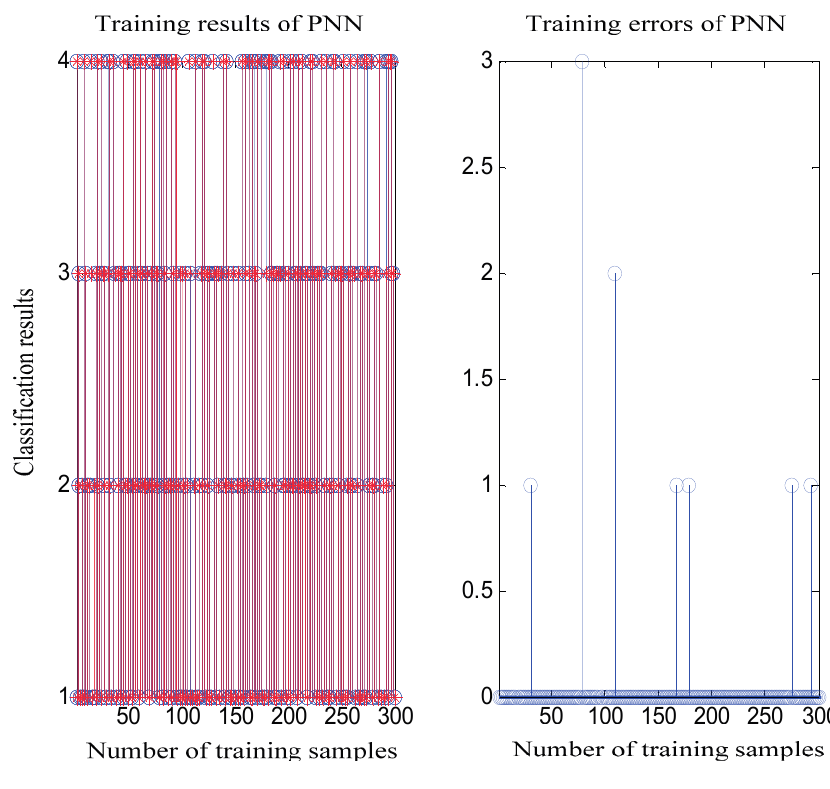
Figure 8. Classification results of PNN under training samples.